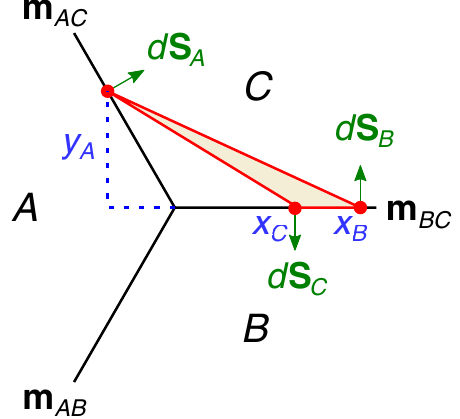
FIG. 13. Representative contribution to the D ¼ 2 integral I in Eq. (D3), where r and r are integrated along ray ˆ m B C integrated along rays ˆ m and ˆ m . The δ function in the AB AC integrand requires r , r , and r to lie on the same straight line, A B C hence placing r at the triple point. The remaining integrations A and r lead to a log 2 over r B C